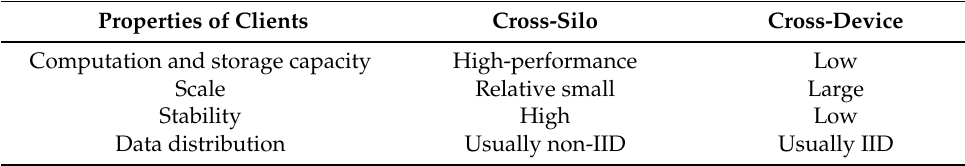
Table 2. Properties of FL